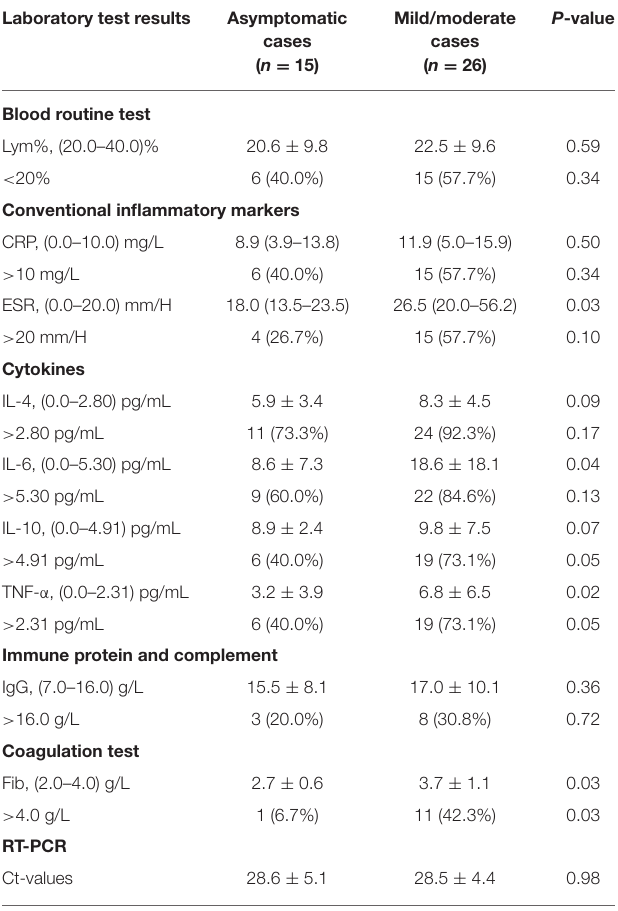
TABLE 3 | Statistical analyses of abnormal biochemical indicators in asymptomatic cases and mild/ moderate cases. Laboratory test